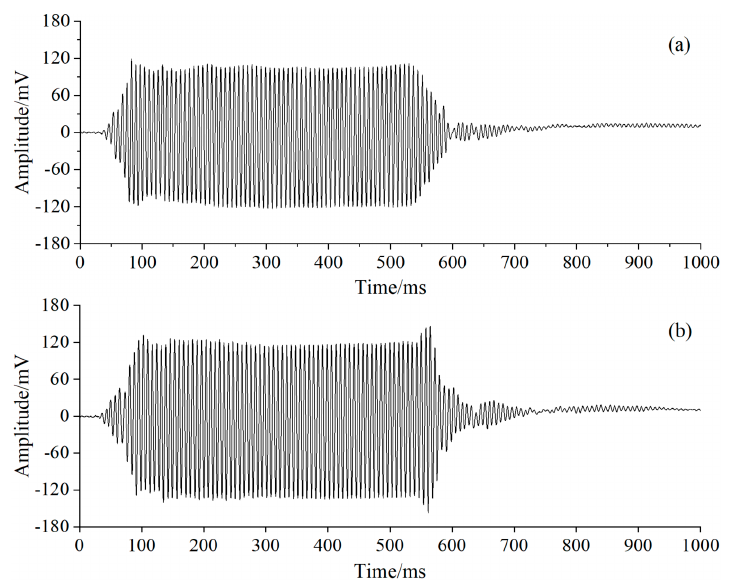
Figure 13. The time-domain waveform of AE by the AW method: ( a ) Excitation position is 50 mm; ( b ) excitation position is 150 mm.